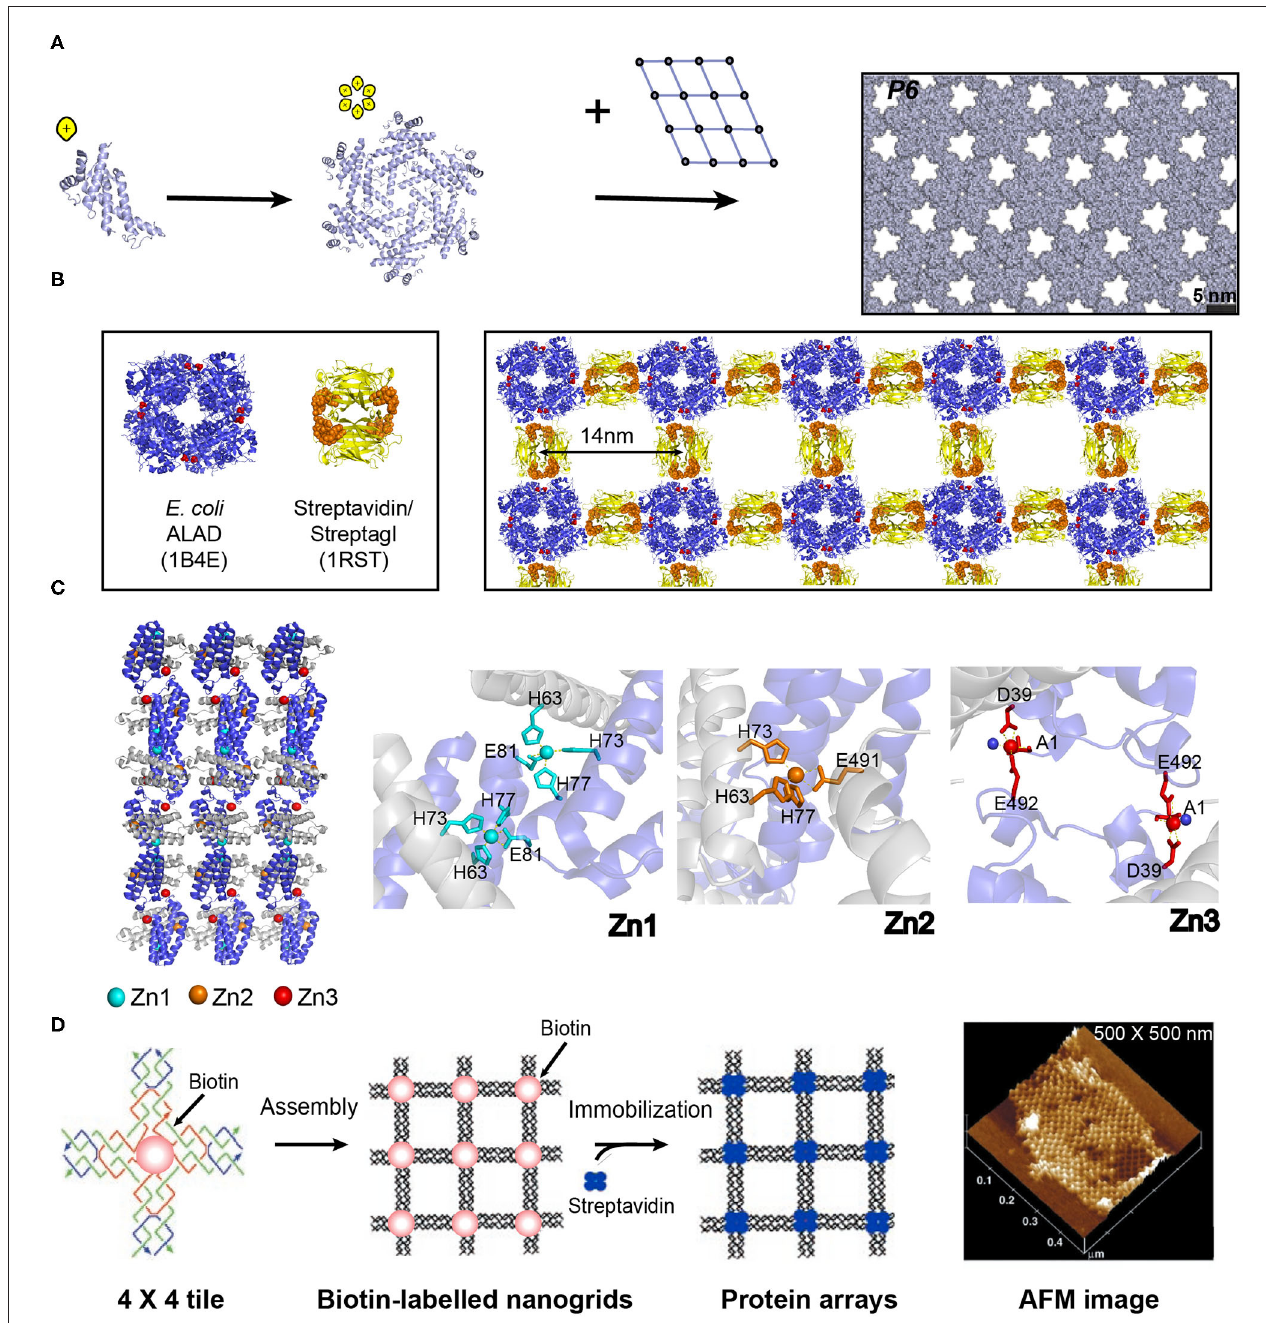
FIGURE 5 | Self-assembled 2D protein arrays generated by different strategies. (A) The protein-based 2D lattice ( P 6) generated by the computational design strategy. Reproduced with permission from Gonen et al. (2015). Copyright 2015 The American Association for the Advancement of Science. (B) The 2D crysalin lattice generated by the symmetry-guided protein assembly strategy. (C) The molecular arrangement in a 2D Zn 2 + -RIDC3 sheets (Left). Three types of Zn 2 + coordination interactions that enable the self-assembly of RIDC3 (Right). (D) 2D arrays generated by the template-directed strategy using 4 × 4 DNA nanogrids via biotin-streptavidin interactions. Adapted with permission from Yan et al. (2003). Copyright 2003 The American Association for the Advancement of Science.